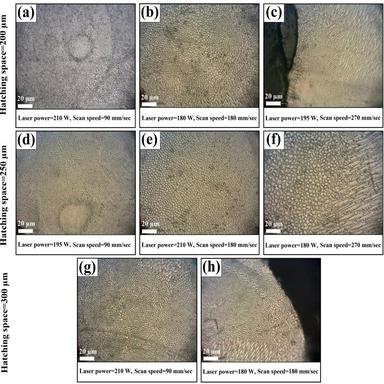
The grain structure of LPBF printed nanocomposite materials from the top cube surface by variation of hatching space at three different levels of (a-c) 200, (df) 250, and (g, h) 300 µm by changing the laser power and scanning speed within the ranges of 180–210 W and 90–270 mm/sec, respectively, for a constant thickness of feeding powder of ~ 40 µm.